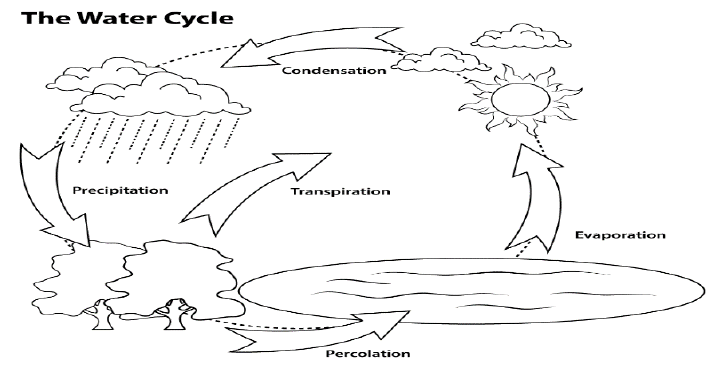
Figure 2. A simplified diagram of the water cycle (the hydrologic cycle) [37].